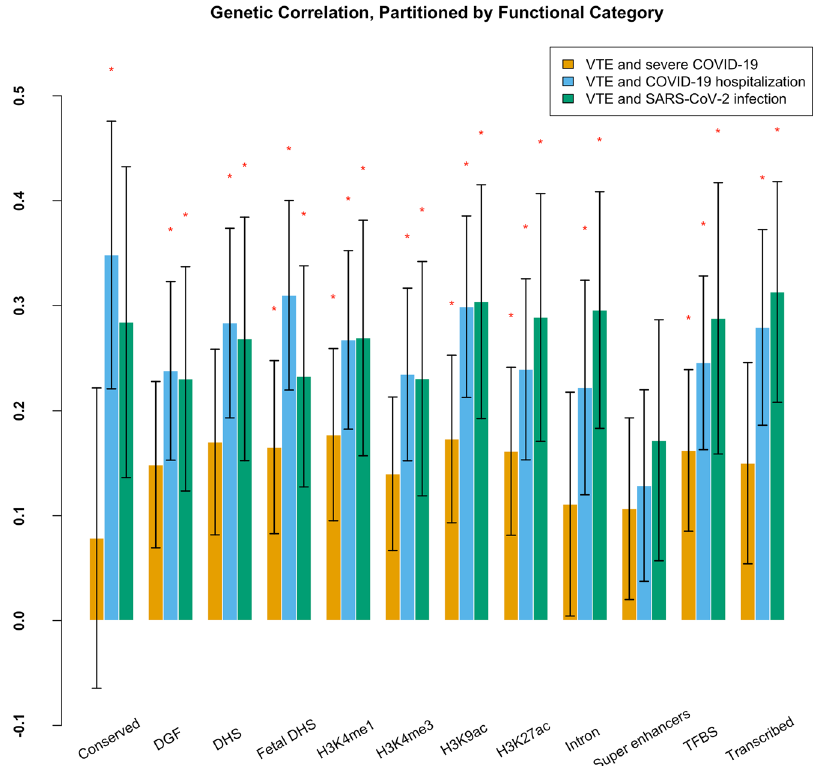
Fig. 2 Partitioned genetic correlation between VTE and COVID-19-related traits. Results were derived from partitioned linkage disequilibrium score regression (LDSC) analysis. The x axis represents the 12 functional categories, and the y axis represents the estimated partitioned genetic correlation. The signi fi cant functional categories ( P < 0.05) are starred. Error bars represent the standard error of genetic correlation estimates. DGF DNaseI digital genomic footprinting, DHS DNase I hypersensitivity site, TFBS transcription factor binding sites. The presented data are available in Supplementary Data 7.